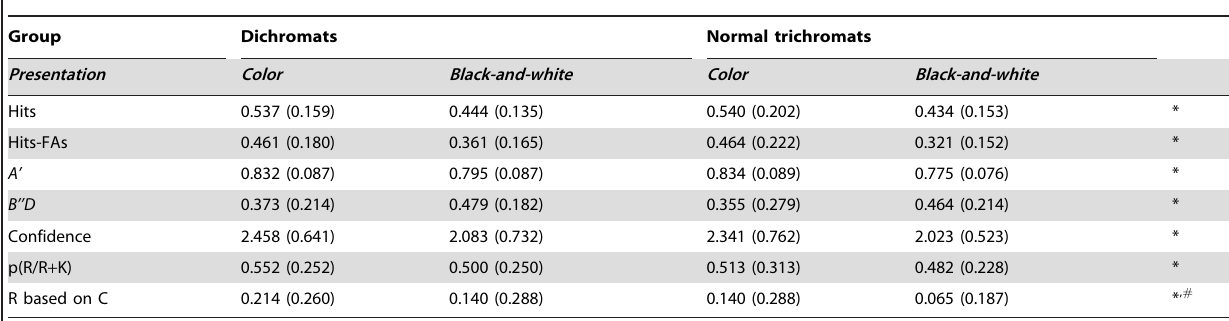
Table 1. Mean scores of accuracy (Hits, Hits-FAs), discrimination ( A’ ), bias ( B’’D ), response confidence, proportions of Remember hits, and proportions of Remember responses based on color information as a function of the group of participants and the mode of